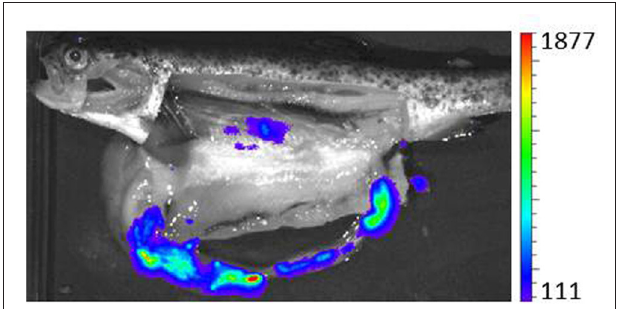
FIGURE 1 | Bioluminescent tracking of Y. ruckeri harboring pCS26-Pac in a fish infected by bath immersion with 10 7 cfu ml − 1 for 1h. Bioluminescence emitted by the bacterium was captured three days postinfection by Ivis-Lumina equipment. Color standards represent “RLU max.” This measure expresses the highest number of counts in a pixel inside the region analyzed (Figure taken from Méndez and Guijarro, 2013).